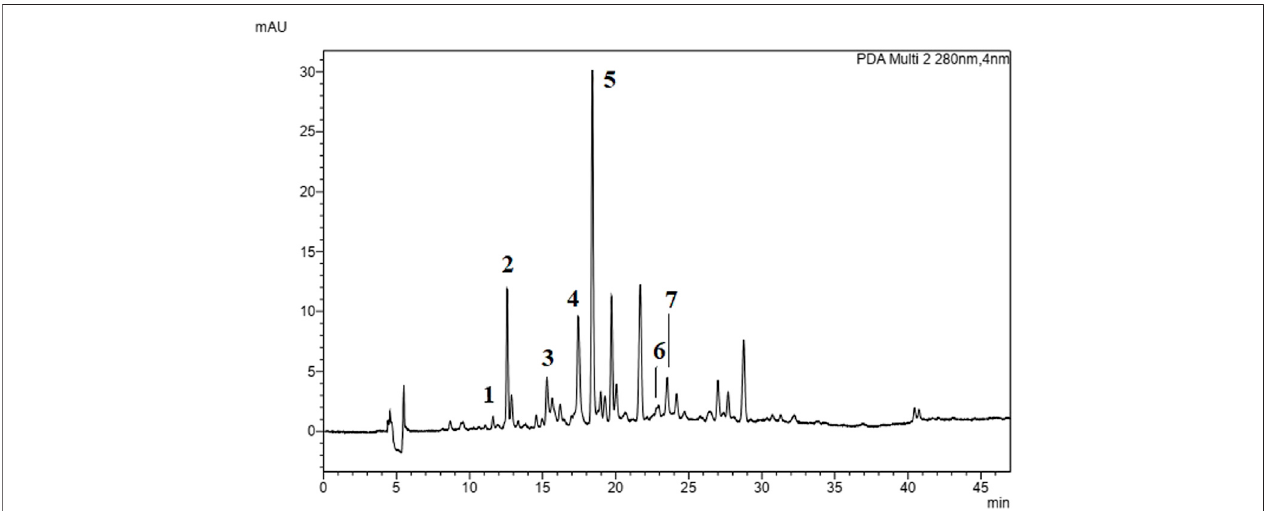
FIGURE2| EABRPUPLC-DADchromatogramat280 nm.1(daidzein),2(liquiritigenin),3(pinobanksin),4(isoliquiritigenin),5(formononetin),6(pinocembrin)and7 (biochanin A).